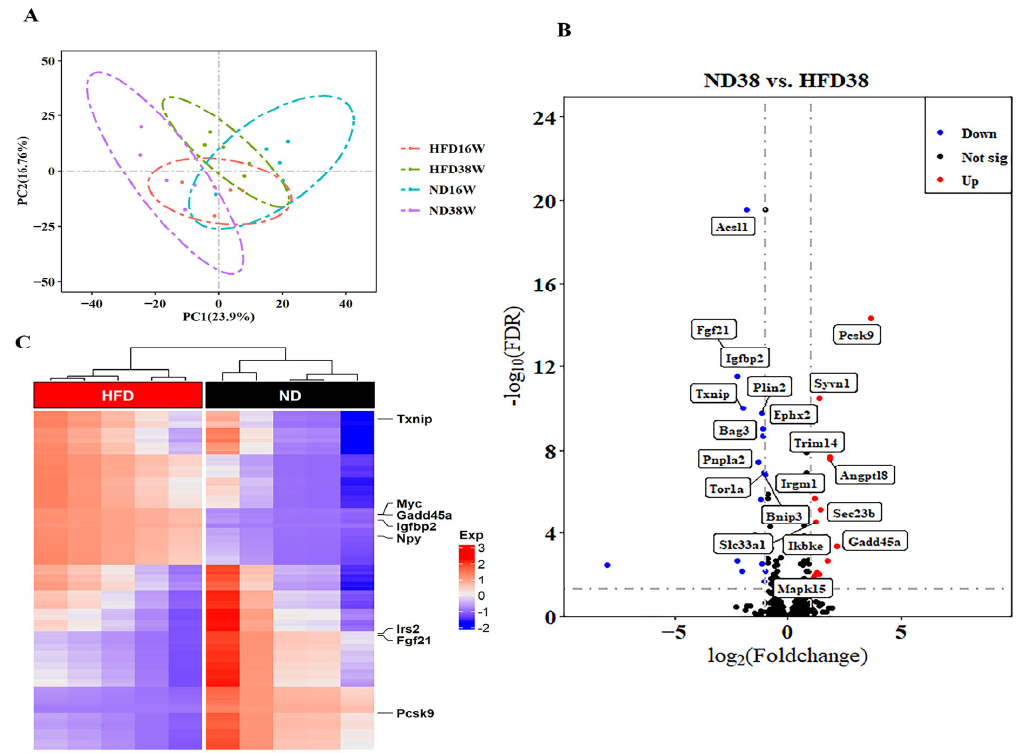
Figure 3. Expression profiles of 786 autophagy genes in the liver after 38 weeks of a high ‐ fat diet. ( A ) Principal component analysis score chart; ( B , C ) Volcanic and heatmaps of identified differentially expressed genes (DEGs) between the livers of mice fed a high ‐ fat diet for 38 weeks and the livers of mice fed a normal diet. The volcanic diagram showed a total of 31 differentially expressed genes, with red dots representing 13 genes upregulated based on the adjusted p value FDR < 0.05 log2 (fold change) > 1. The blue dots represent 1 of the 18 downregulated genes for FDR < 0.05 and log2 (fold change) < 1. Black dots indicate genes whose expression is not significantly different. The boxes in the figure identify the upregulated and downregulated genes in the top ten in FDR order.